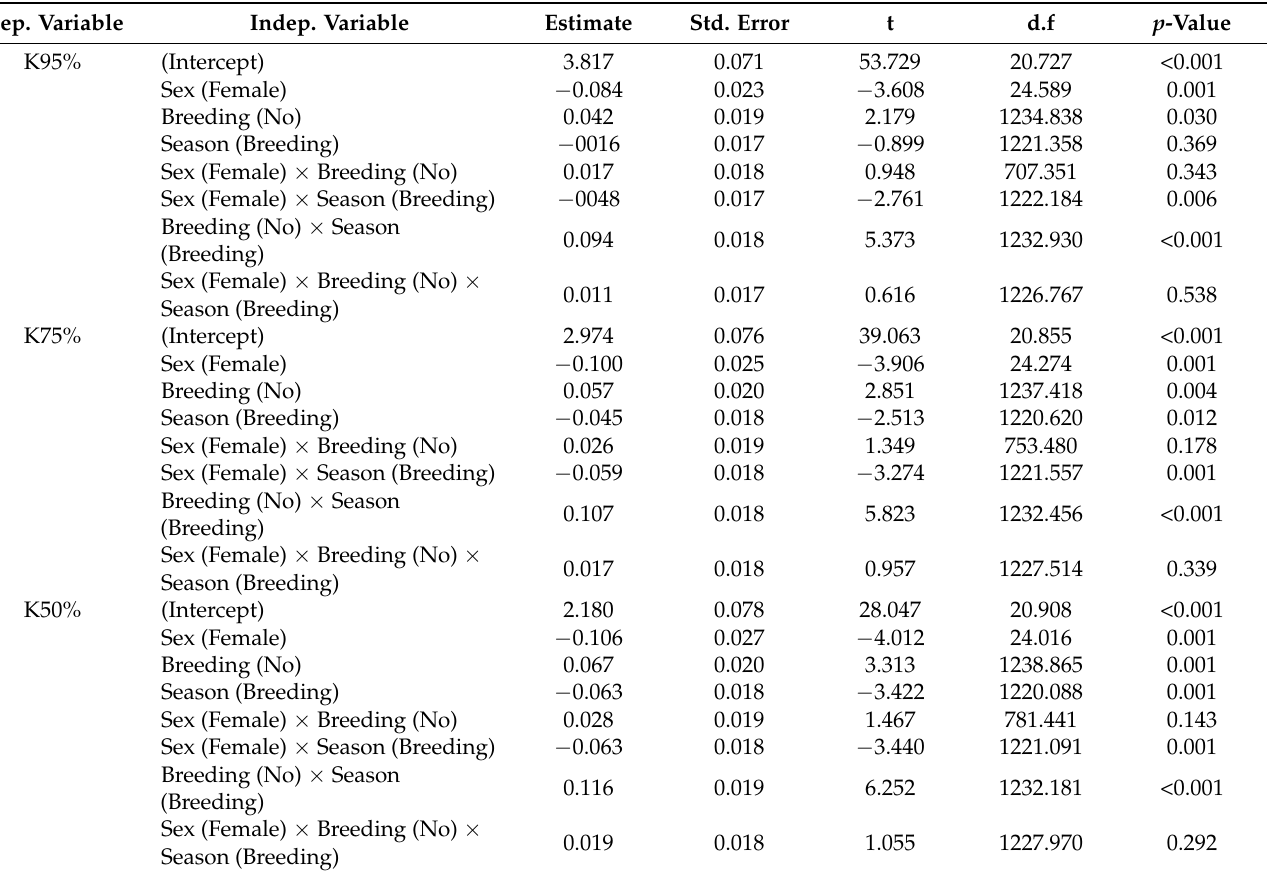
Table 1. Generalized linear mixed model (GLMM) results of variation in home-range size using three different spatial estimators. Significant variables are highlighted in bold.